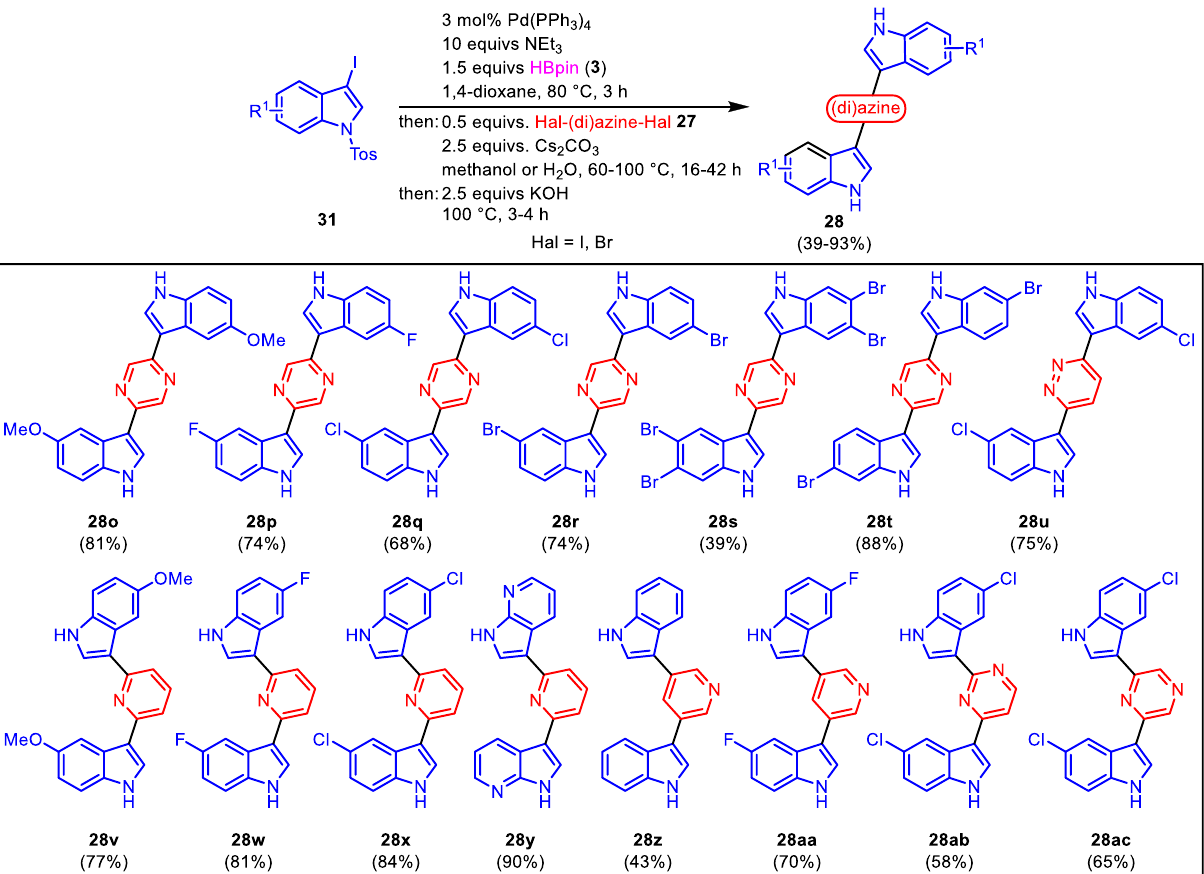
Figure 22. Product scope of the one-pot MBSC synthesis of (di)azine-bridged bisindoles 28 with potent antimicrobial activity against MRSA [52].